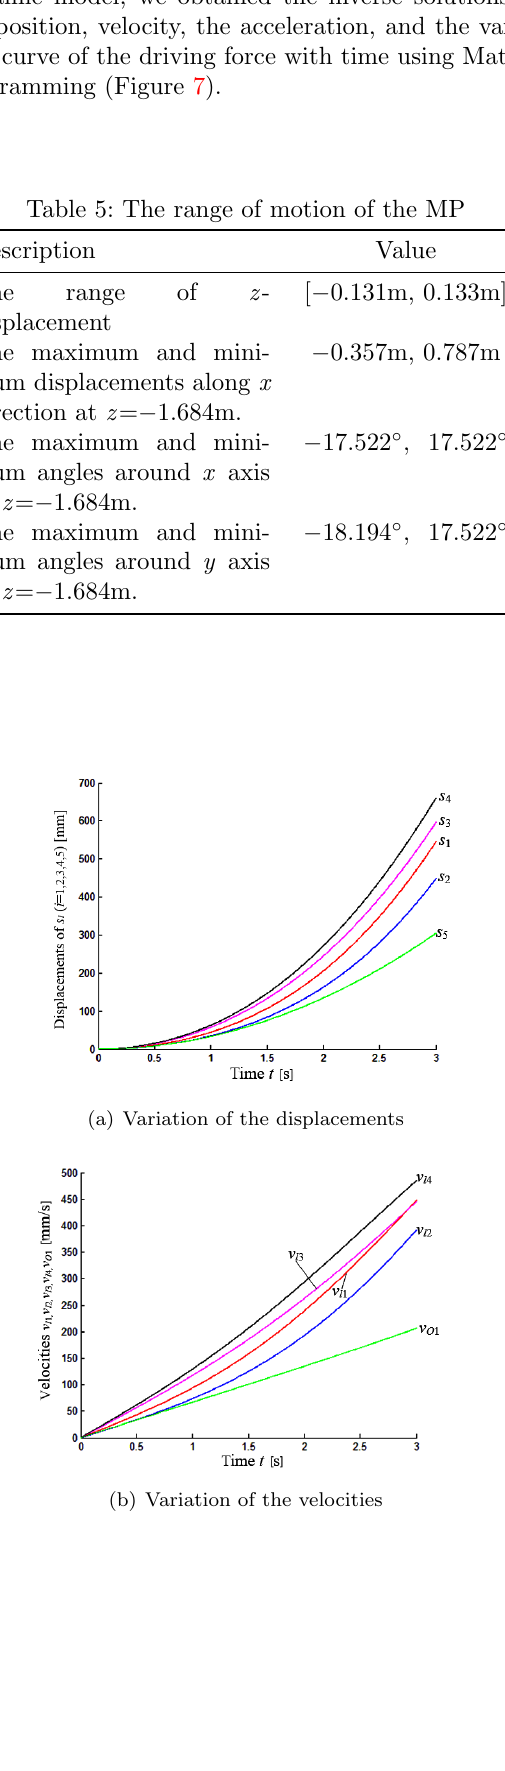
Figure 9: The slender structural